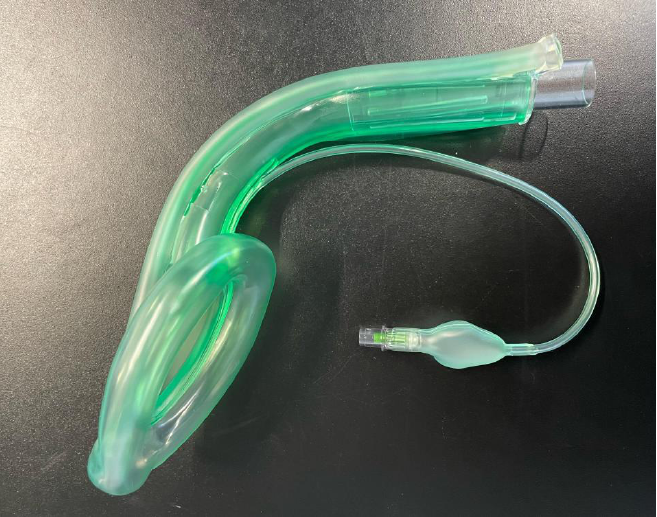
Figure 2. Ambu ® Aura Gain TM .